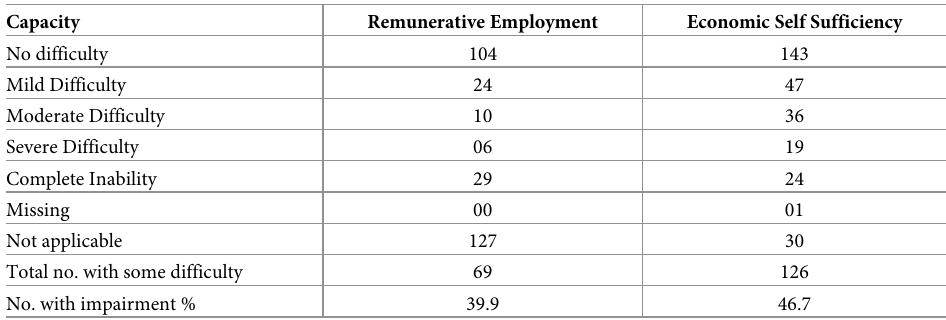
Table 9. Difficulties in economic